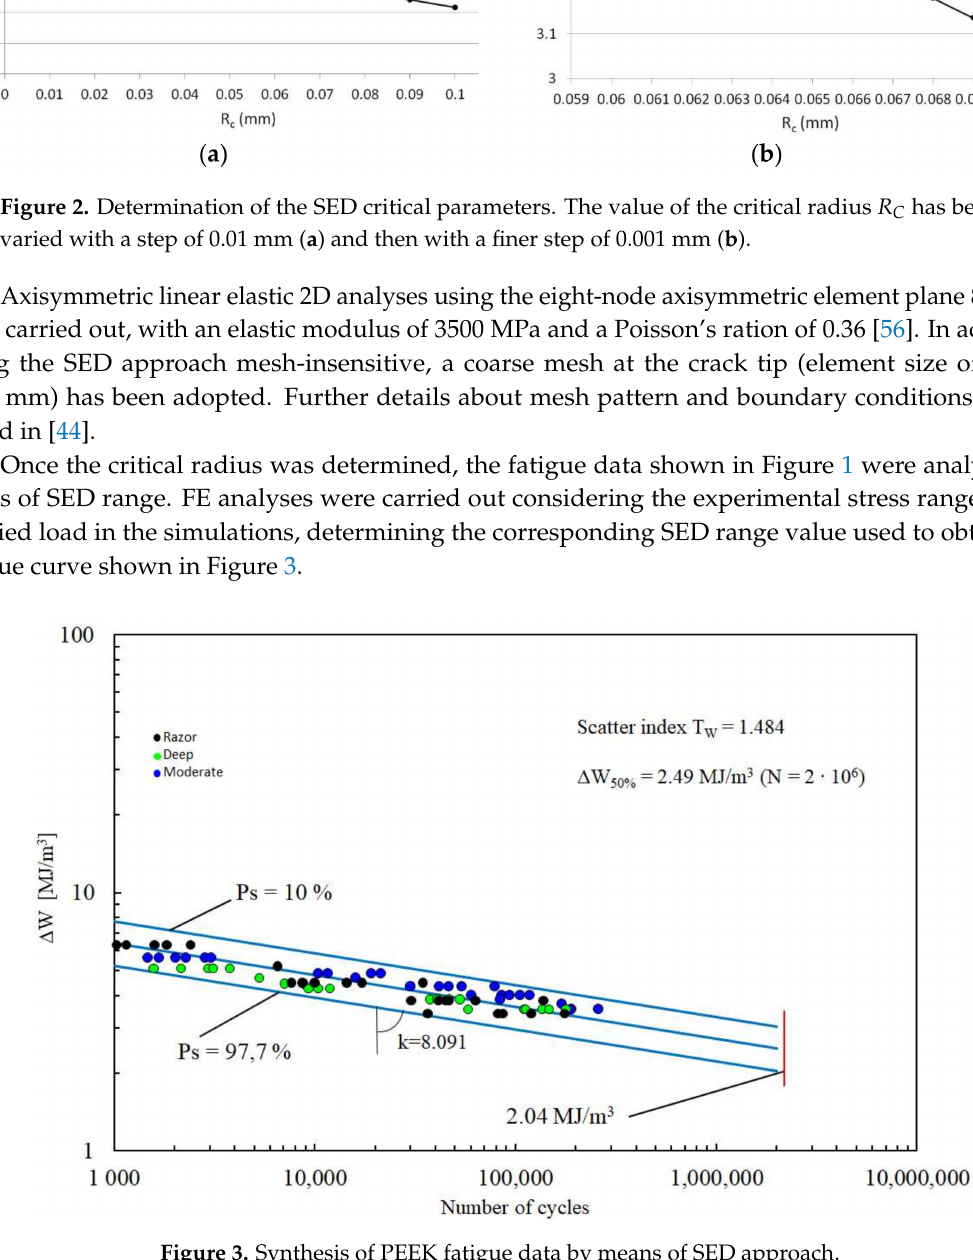
Figure 3. Synthesis of PEEK fatigue data by means of SED